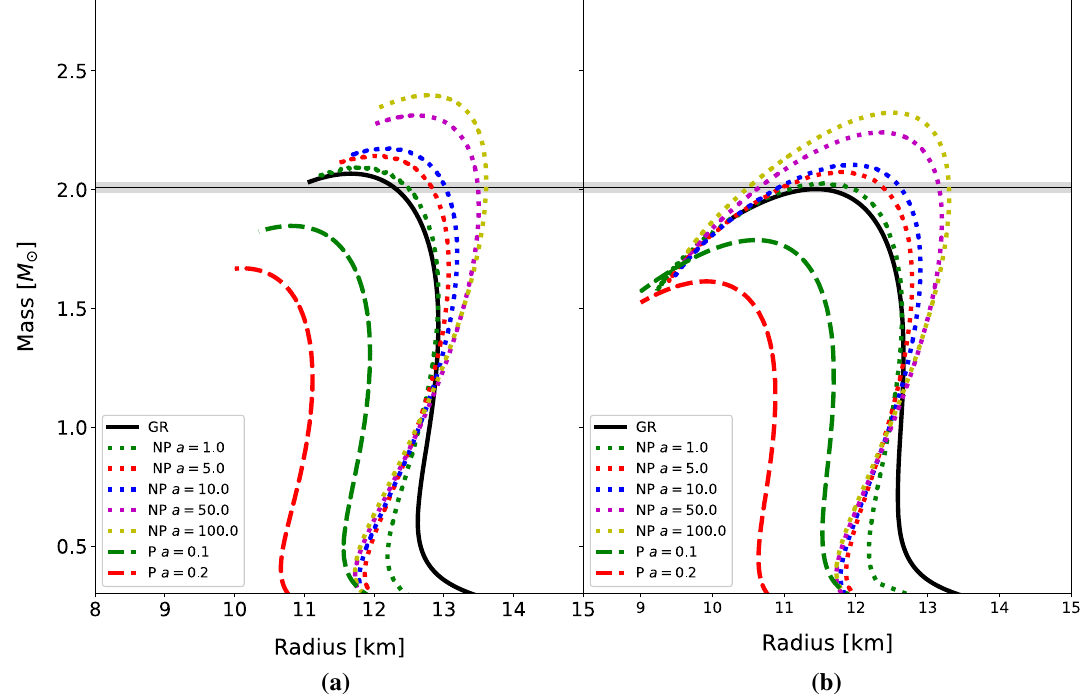
Fig. 3 a MR curves of EoS FSU obtained using both perturbative (dashed lines) and non-perturbative (dotted lines) methods. b MR curves of EoS FSUQ obtained using both perturbative (dashed lines) and non-perturbative (dotted lines)